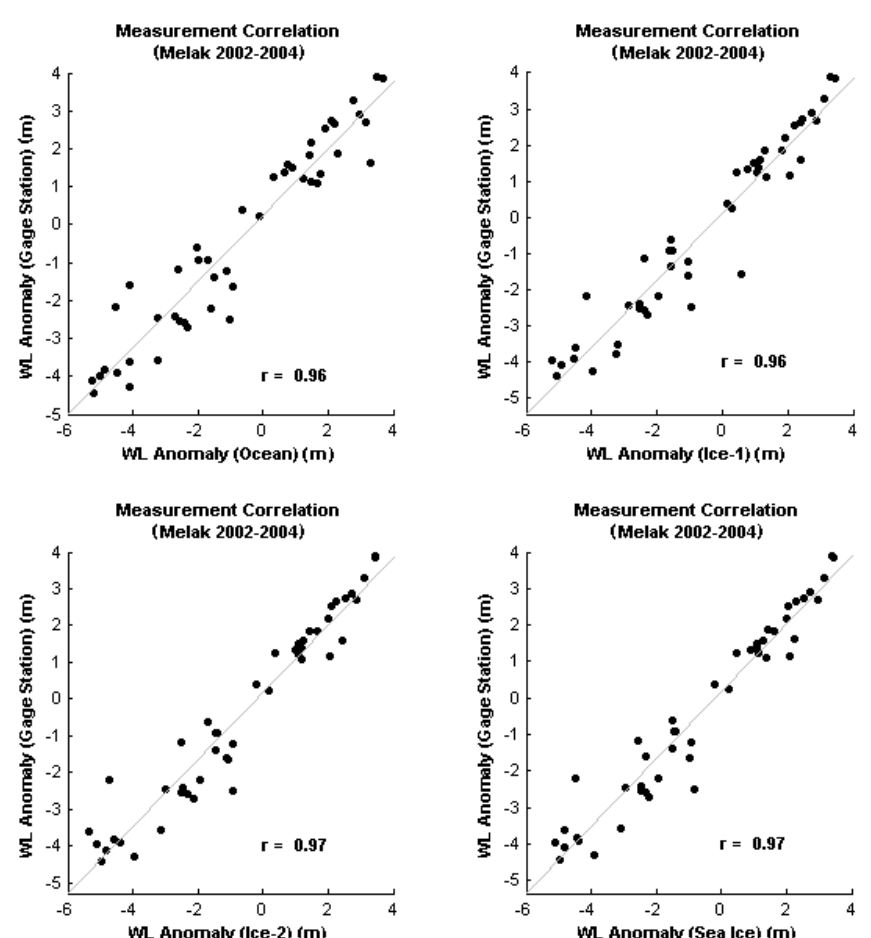
Figure 7. Correlation between the water level anomaly measured by the Envisat altimeter and processed with the Ocean (top left panel), Ice-1 (top right panel), Ice-2 (bottom left panel) and Sea Ice (bottom right panel) retrackers and the in situ water level measurement over